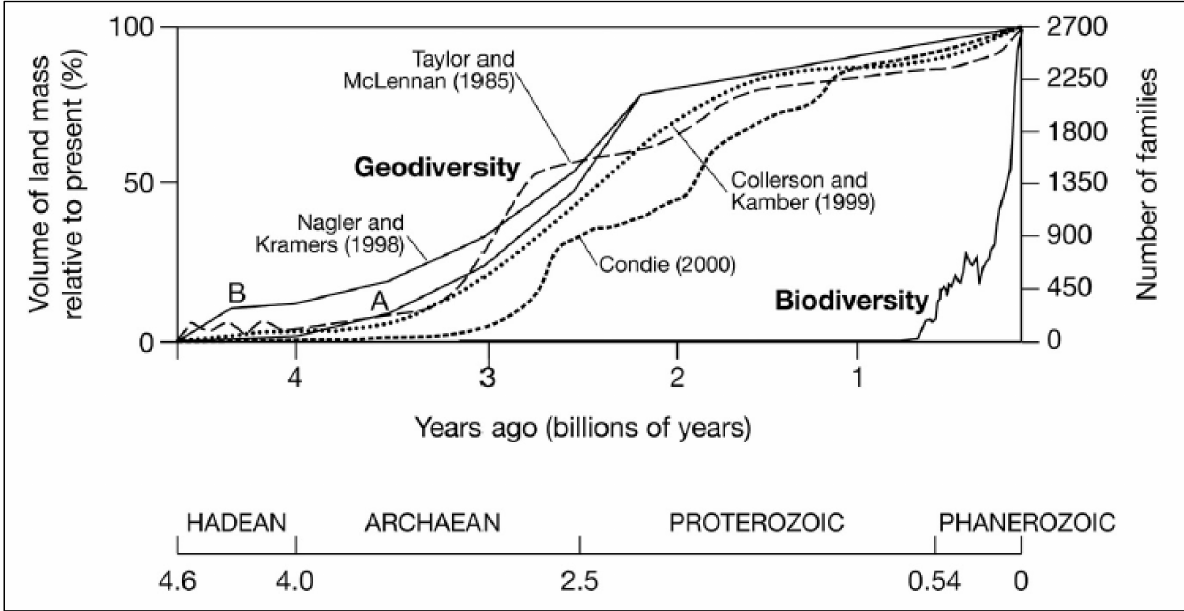
Figure 1. Curves of developing geodiversity and biodiversity, after Gray et al., [6], reprinted with permission from Gray et al., 2022, Elsevier. license no.